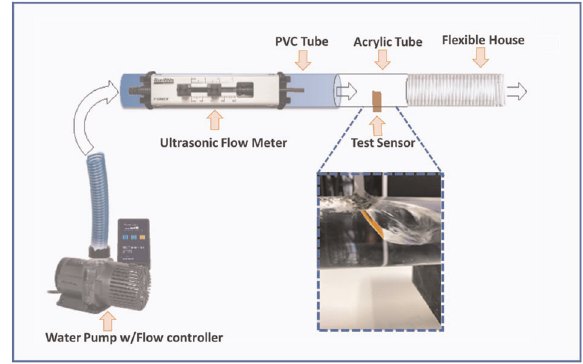
Fig. 4 Schematic of the fl ow test setup. The inset shows the bending the LIG sensor toward the direction of fl uid fl